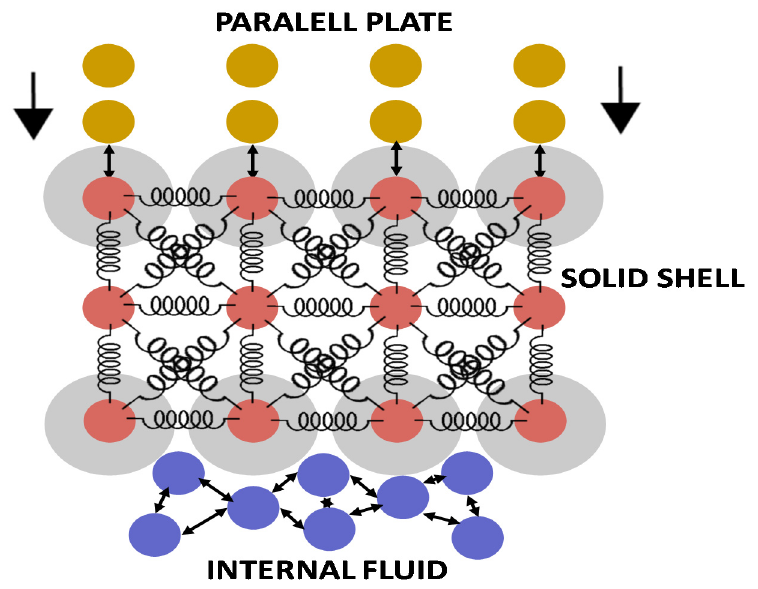
Figure 1. Particle representation and interactions among the computational particles.